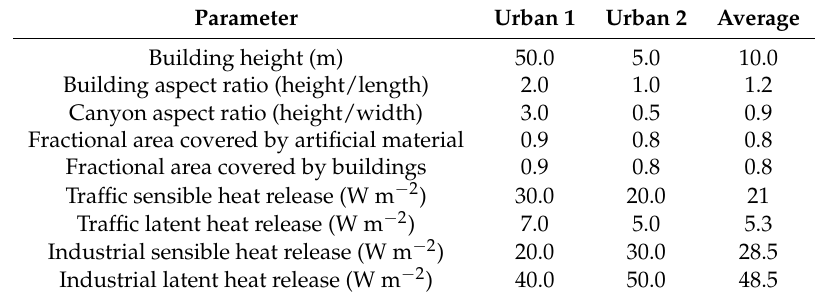
Table 3. Differences between the parameters for the two urban areas above the metropolitan area of São Paulo (MASP) [46] and the average values used in the tropical town energy budget (tTEB) scheme.